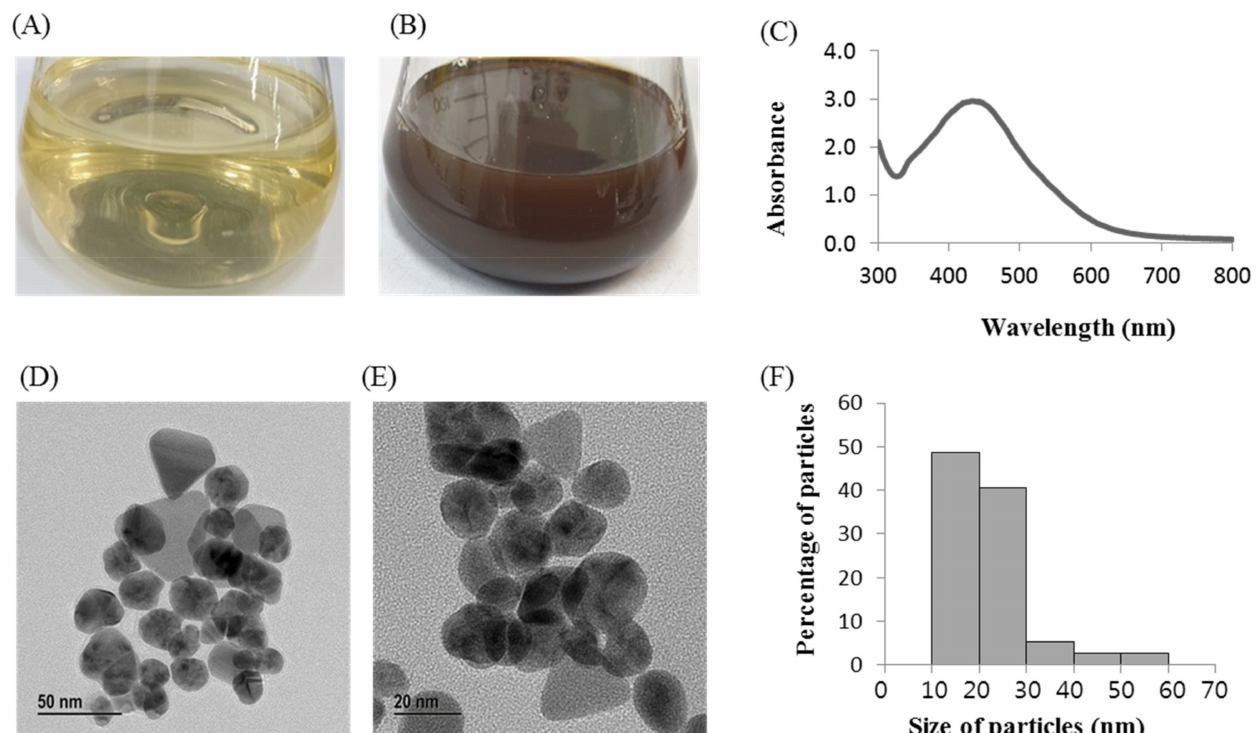
Figure 2. R2A broth with AgNO 3 as control ( A ), Massilia sp. MAHUQ-52 mediated synthesized AgNPs ( B ), UV–vis spectra ( C ), FE-TEM images of synthesized AgNPs ( D , E ) and histogram of various sizes of synthesized AgNPs ( F